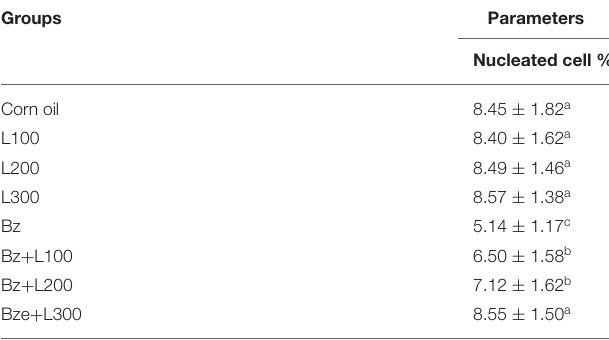
TABLE 4 | Effect of bovine lactoferrin on bone marrow cellularity in benzene-induced hematotoxicity. Groups